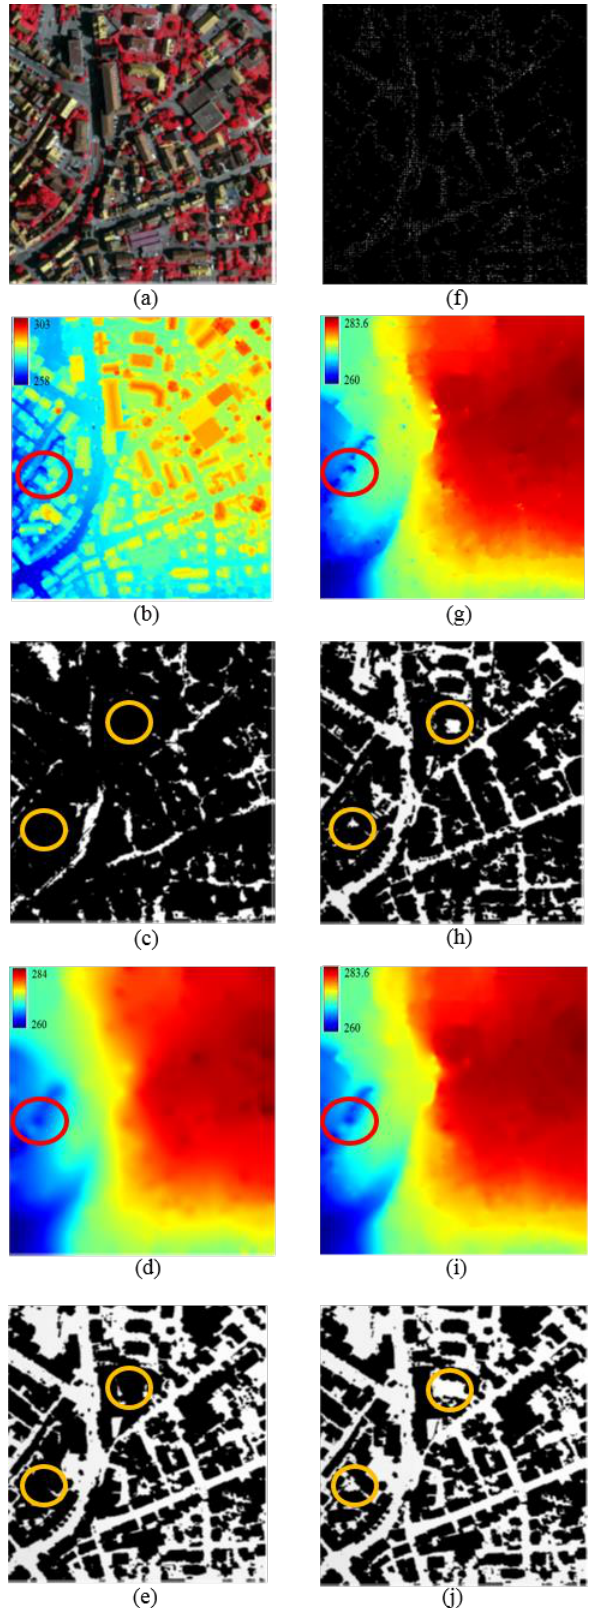
Figure 5. Ortho image for area1 (a) and input DSM (b). Ground mask (c), DTM (d), and nDSM (e) by MSD method. Network of ground points (f), initial DTM (g), ground mask (h), final DTM (i), and nDSM (j) by NGPs